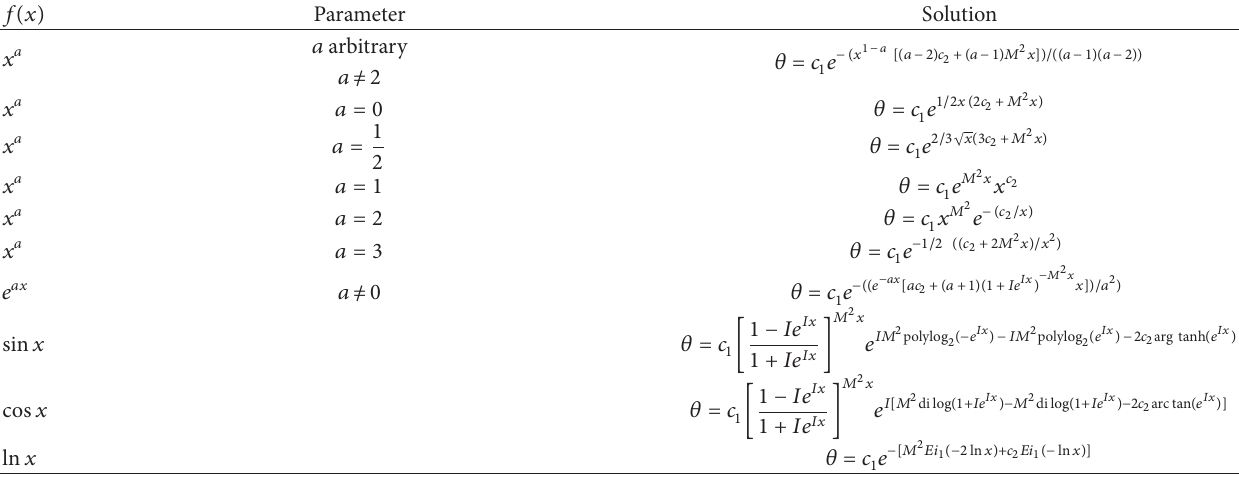
Table 5: Solution for 𝑚 = 𝑛 = −1 .